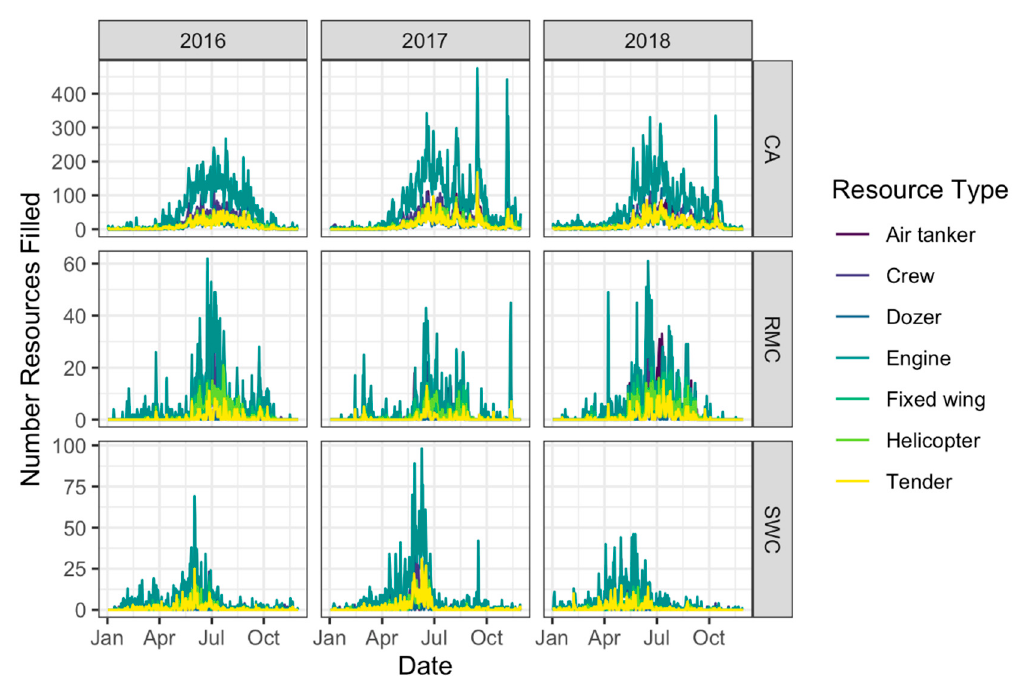
Mach. Learn. Knowl. Extr. 2021 , 3 FOR PEER REVIEW Figure A1. Number of resources ordered and filled during each day from 2016 to 2018 in the three GACCs tested.